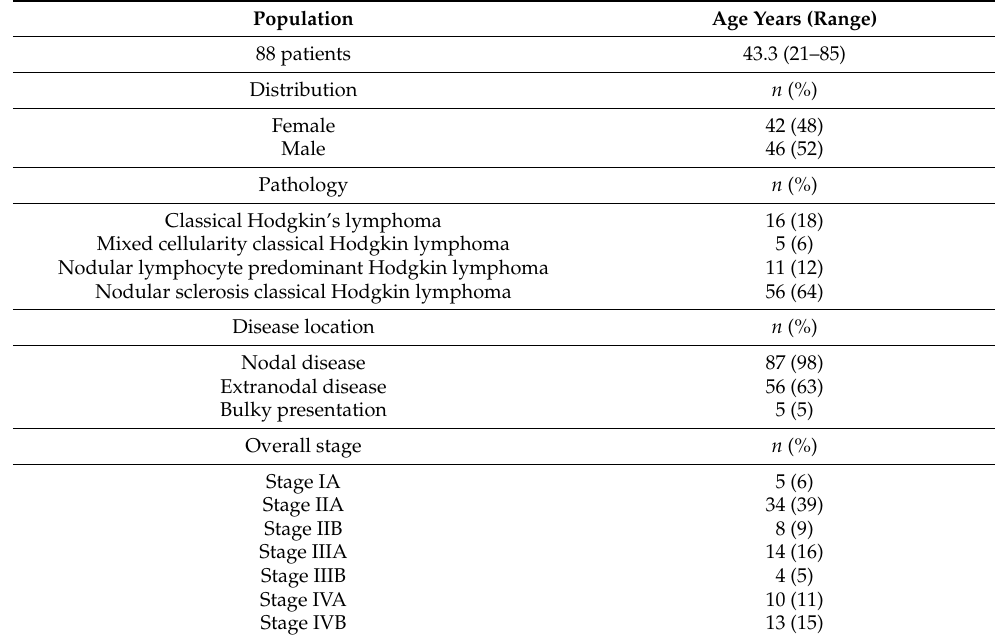
Table 1. Summary of patient population